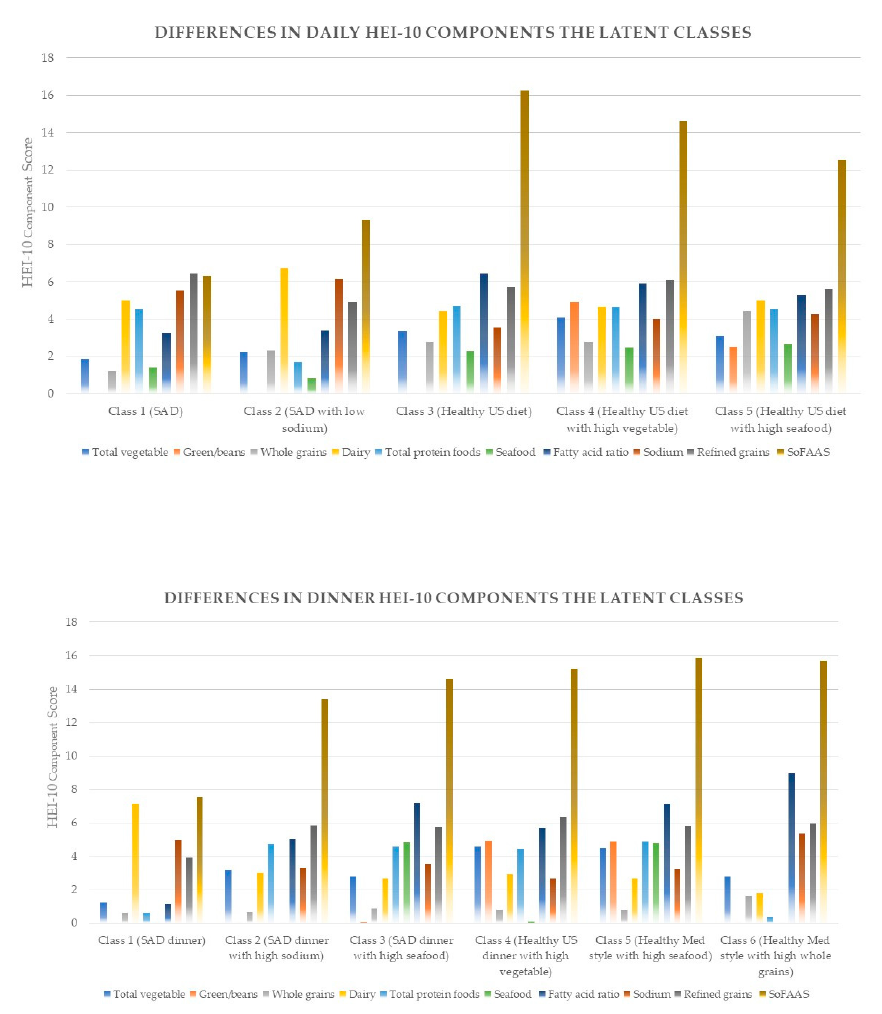
Figure 2. Latent classes representing differences in the daily and dinner HEI-2010 components of the NHANES 2007–2010 sample population (age ≥ 19 years).